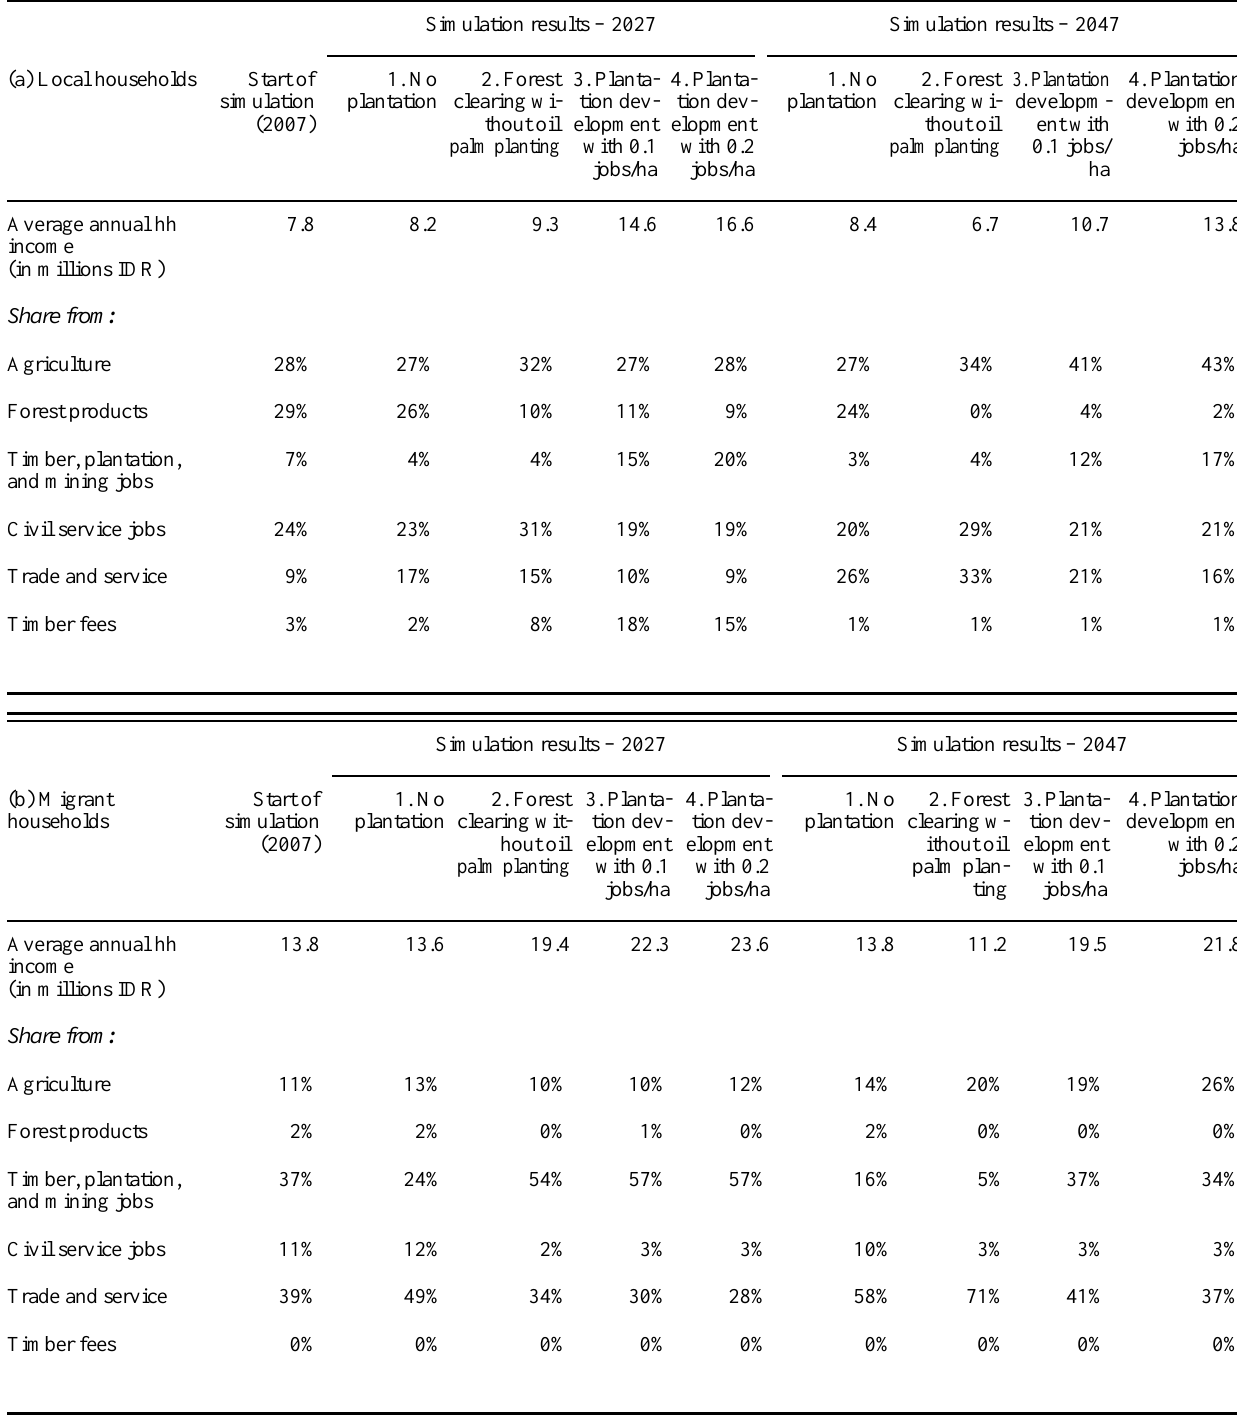
Table 4. Average annual cash income (millions IDR) for (a) local households, and (b) migrant households; and percentage contribution of each activity to annual income, under four different